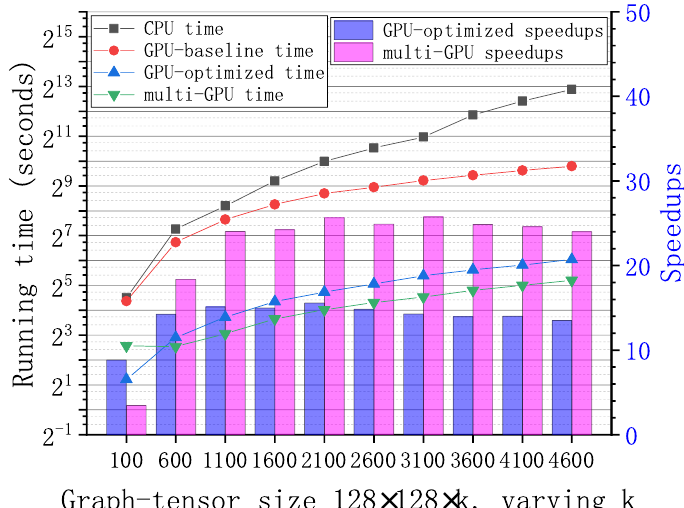
Figure 7. Running time of the GPU-base baseline, optimized, and multi-GPU implementations and the CPU MATLAB implementation with synthetic graph-tensors of 128 × 128 × k . Speedups of the GPU-optimized and multi-GPU implementations